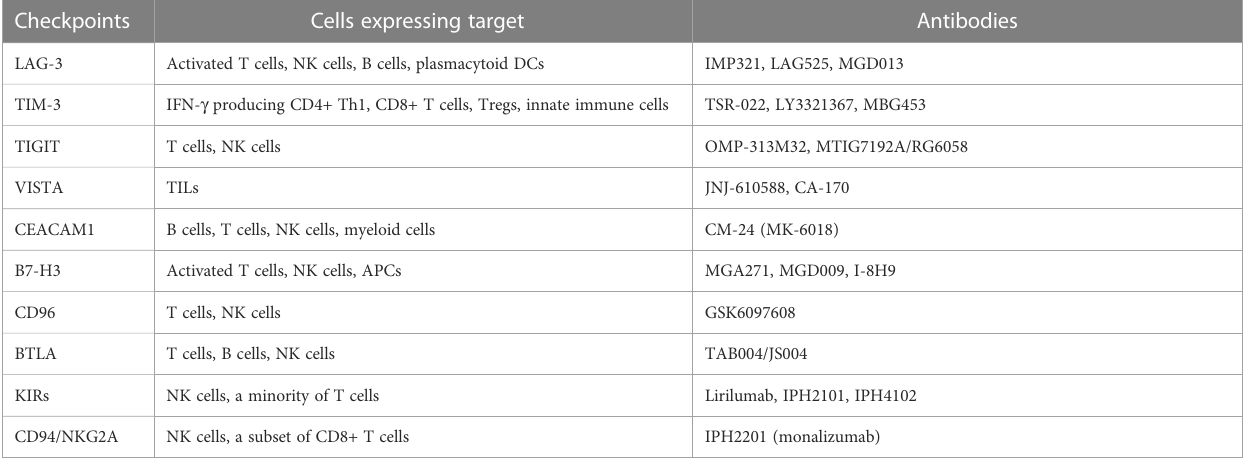
TABLE 8 Current ICI drugs in clinical trials (not yet